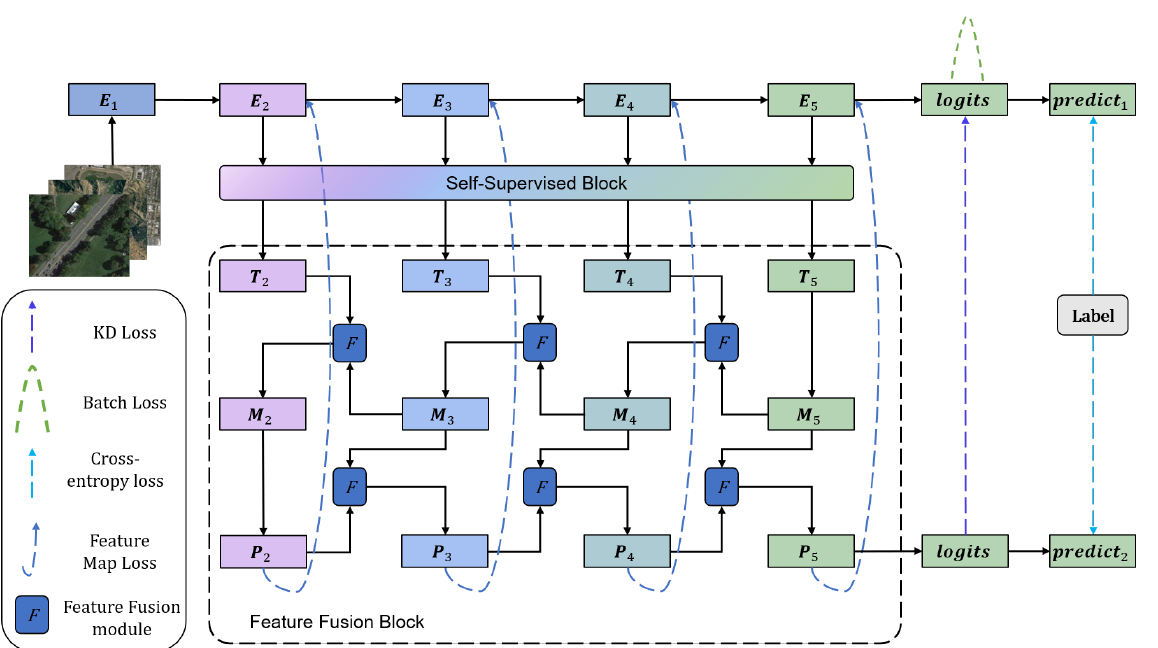
Figure 2. Structure of SSKDNet. The backbone feature maps E 1 – E 5 are the baseline structure Cycle MLP pre-trained on ImageNet; the feature maps T 2 – T 5 represent the output from the self-supervised block; the feature maps M 5 – M 2 represent the top-down path; and the feature maps P 2 – P 5 are the bottom-up